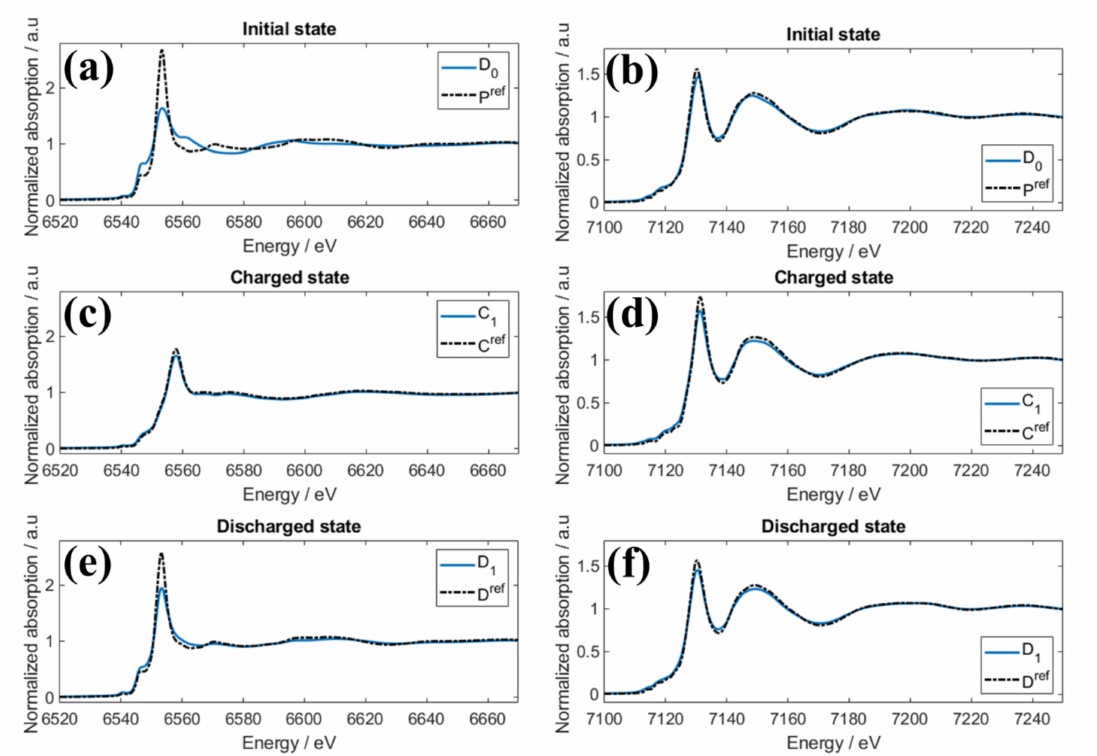
Figure 3. Spectra at Mn and Fe K-edges for the initial, charged, and discharged states of charge. Each panel illustrates the comparison of the spectra recorded in the previous work and the ones reported in Reference [11]. The Mn K-edge for the initial, charged, and discharged states is displayed in panels ( a ), ( c ), and ( e ), respectively, while the analog series at the Fe K-edge is displayed in panels ( b , d , f